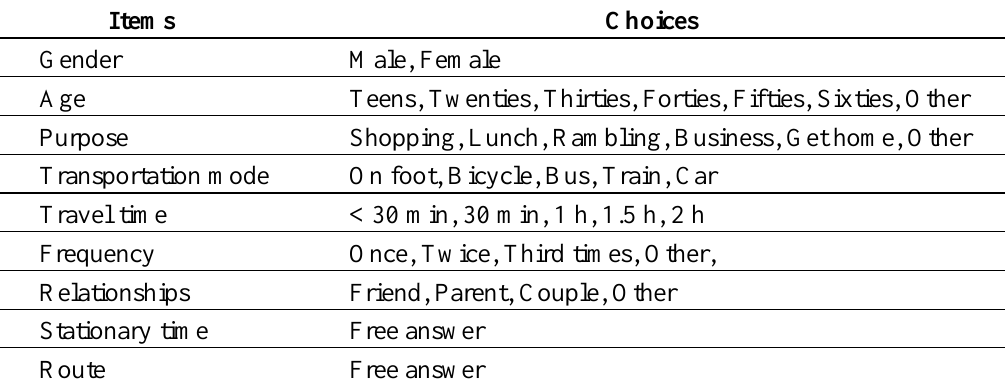
Table 6. Questionnaire items.